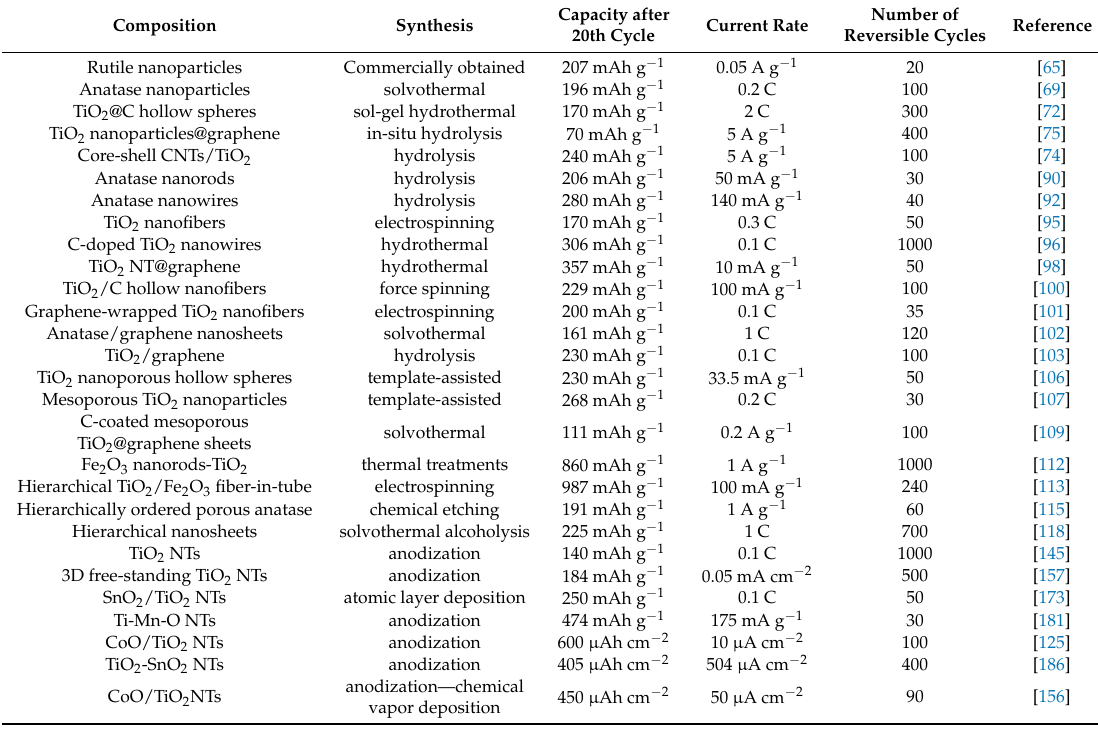
Table 2. Electrochemical performance of various TiO 2 nanostructure based